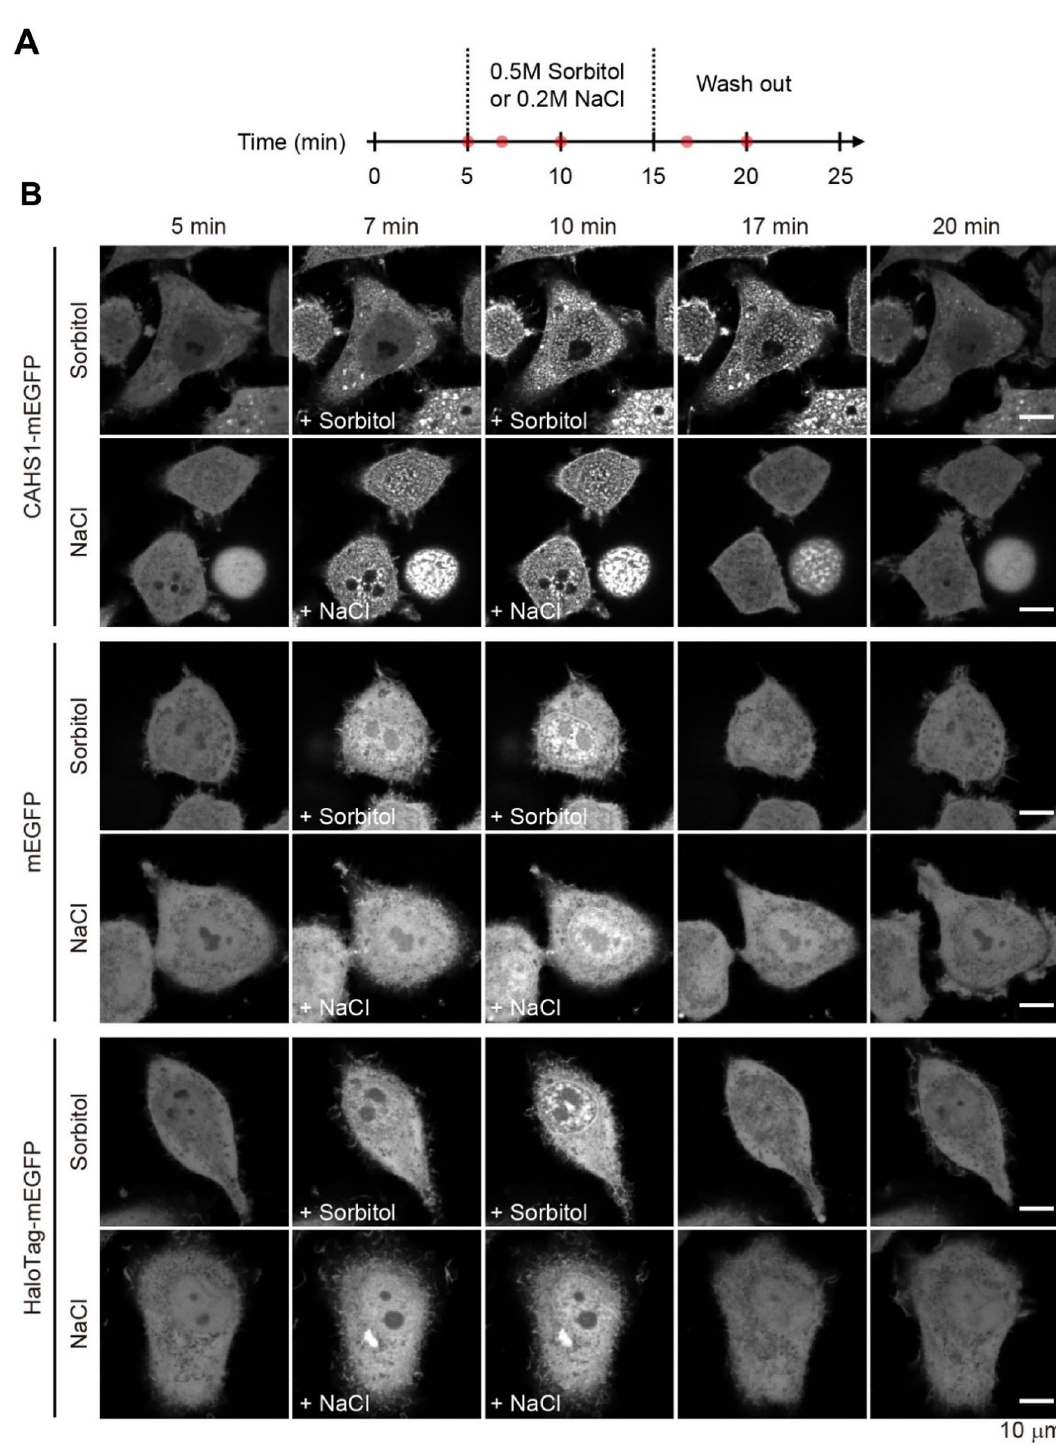
Figure 3. Real-time monitoring of the reversible formation of CAHS1 protein particles. ( A ) Timeline of time- laps imaging with hyperosmotic shock. The red dots represent the time points when the representative cells are presented in panel ( B ). ( B ) Time-laps images of HeLa cells overexpressing the CAHS1-mEGFP, mEGFP, and Halo Tag-mEGFP proteins. A sorbitol or sodium chloride solution was added at 5 min. After 10 min, the cells were washed with a flesh medium using a microfluidics